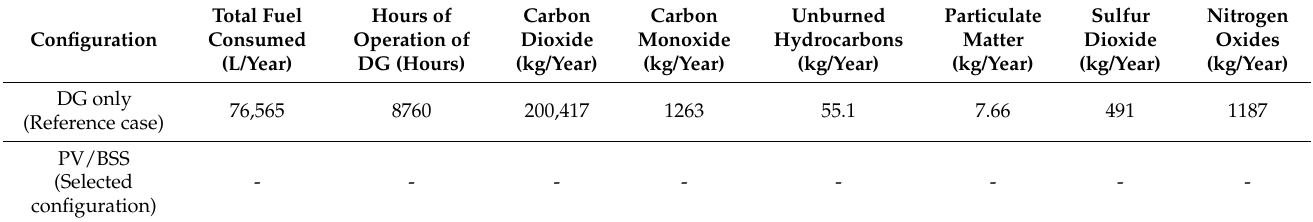
Table 13. Comparison of emission of pollutants to the atmosphere between the selected configuration of HPGP and the reference